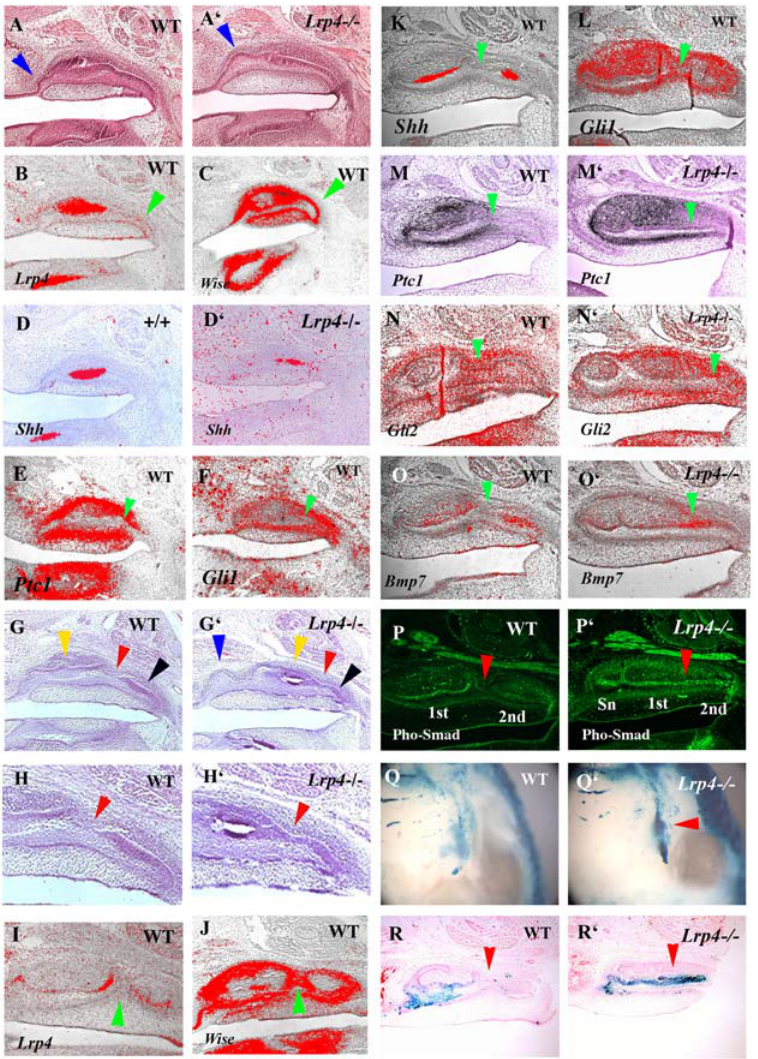
Figure 7. Shh, Bmp and Wnt signalling in fused maxillary molars. Sagittal section showing tooth bud epithelium of a supernumerary tooth in Lrp4 mutant at E14.5 (arrowhead in A’) and E16.5 (Supernumerary tooth; blue arrowhead, the first molar tooth germ; yellow arrowhead, the second molar tooth germ; black arrowhead in G’). Transient epithelial swelling of vestigial remants of diastema tooth in wild-type at E14.5 (arrowhead in A) and no swelling at E16 (G). Weak expression of Lrp4 (B) and strong Wise (C) were observed at the posterior part of tooth germ at E14.5 (arrowheads in B, C). Shh expression domain was reduced in Lrp4 mutants (D’). Ptc1 (E) and Gli1 (F) expression are found at posterior part of tooth germ at E14.5 (arrowheads in E, F). The first molar epithelium is still continuous with the second molar epithelium at E16.5 in wild-type (G). The junction region between the first and second molar could be distinguished by the absence of inner enamel epithelium in wild-type whereas Lrp4 mutant showed continuouse inner enamel epithelium from first molar to second molar (red arrowhead in G–H’). H and H’ are high magnification of the junction region in G and G’. Strong Wise expression was observed at the joint region between first and second molars but no Lrp4 expression in the region (arrowheads in I and J). Shh expression are observed in only inner enamel epithelium of the first molar and second molar (K). Gli1 is expressed in junctional epithelium as well as tooth germs (L). Gli2 and Ptc1 expression were not observed in the epithelium of the junction region in Lrp4 mutnats whereas they were expressed in the epithelium of the region (M–N’). Bmp7 were upregulated at the junction region in Lrp4 mutants whereas they were not expressed at the region in wild-type (O, O’). Phosphorylated-Smad1/5/8 (Pho-Smad) was not detected at the junction region in wild-type whereas it was found in region corresponding the junction region in Lrp4 mutant (arrowhead in P and P’). Wnt activity was observed indistinctly in molar region of wild type (Q) whereas it was obvious in molar region of Lrp4 mutant (Q’). Ectopic Wnt activity was also found where supernumerary molar develop (arrowhead in Q’). In wild types, sagittal sections showed Wnt activity were detected in inner enamel epithelium including enamel knot and stratum reticulum whereas it was not observed in the junction region (arrowhead in R). In Lrp4 mutants, Wnt was activated in the junction region (arrowhead in R’). Maxillary molar tooth at E14.5 (A–F) and E16.5 (G–R’) of wild-type (A, B–D, E–G, H, I–M, N, O, P, Q, R) and Lrp4 mutant (A’, D’, G’, H’ M’, N’, O’, P’, Q’ R’). Histology (A, A’, G–H’), immunohistochemistry (P and P’), b -gal activity (Q–R’) and radioactive in situ hybridisation (B–F, I–Q’) on oral view (Q and Q’) and sagittal sections (A–P’, R,